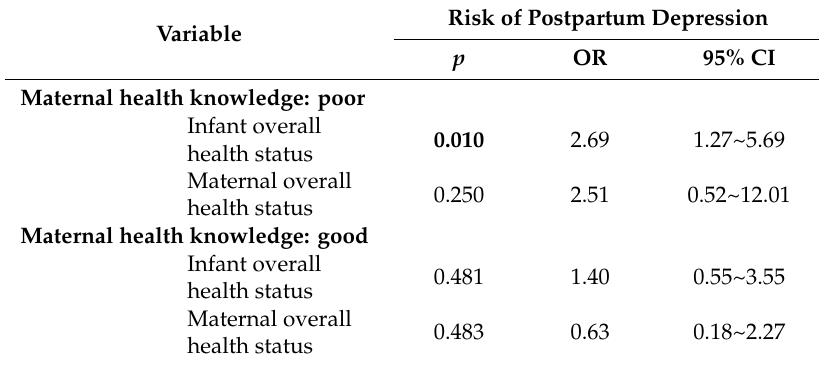
Table 3. Logistic regression on the correlation in two subgroups of maternal health